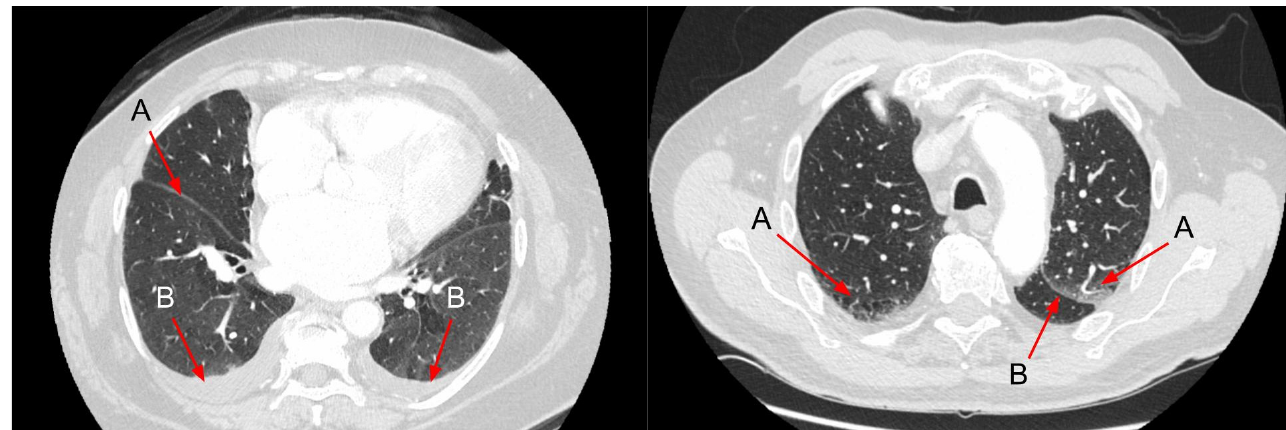
Figure 11. ( left ) Image of the lungs in CT in a patient with HF. Note the non-homogenous increased diffuse parenchymal density of the lungs. A: Thickening of interlobar fissure; B: Bilateral pleural effusion. ( right ) A: Cephalisation—widened upper lobe vasculature. B: Thickening of interlobar fissure and marginally increased density of the interstitium with a patchy appearance in the gravity-dependent part of the lungs within the lobes. Figure obtained with permission from the 2nd Department of Radiology, Medical University of Warsaw.